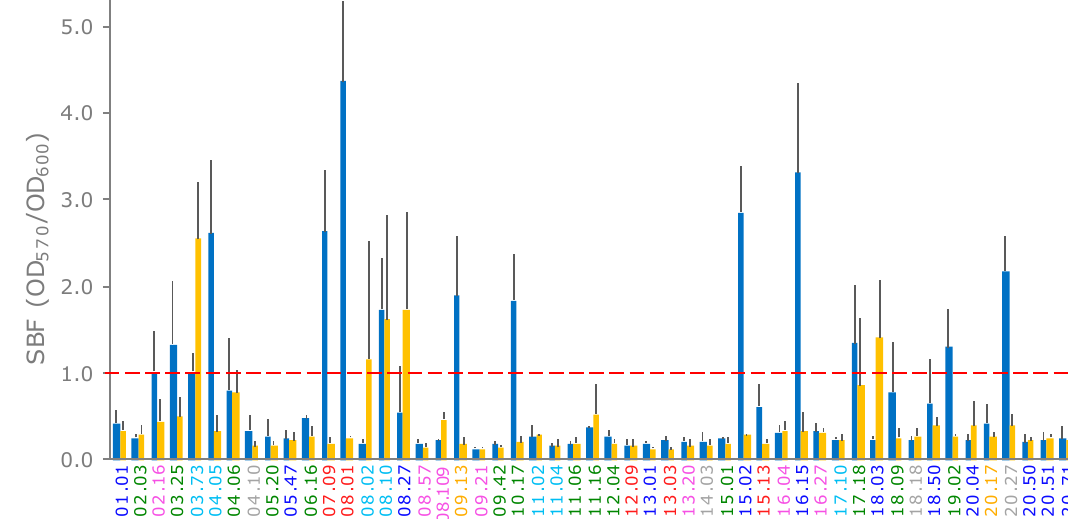
Figure 5. formation of E. coli strains on LBWS (blue bars) and M9glu (yellow bars). The specific biofilm formation index (SBF) is calculated as the ratio between the crystal violet absorbance at 570 nm and the culture turbidity at 600 nm, setting a threshold of 1 for biofilm producers (red dashed line). The reported data are means ± standard deviations of at least three independent experiments, each carried out in triplicate. The names of the strains are colored based on their phylogroups: A, cyan; B1, blue; B2, green; C, yellow; D, red; E, grey; and F, pink (hereafter referred to as LBWS and M9glu, respectively).